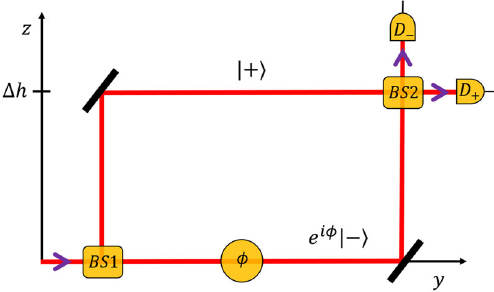
Fig. 1 This figure illustrates a two-way interferometer known as Mach–Zehnder setup. It is made up of two beam splitters BS1, BS2 and two detectors D ± . The superposed system travels along the two paths that are labeled by |±(cid:3) , and it can generally acquire a relative (controllable) phase shift φ . The two detectors D ± measure the degree of interference which appears on the screen as an interference